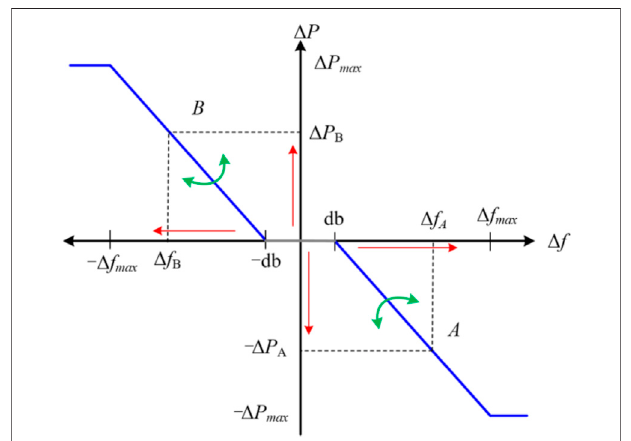
FIGURE 4 | Characteristics of the droop control strategy.